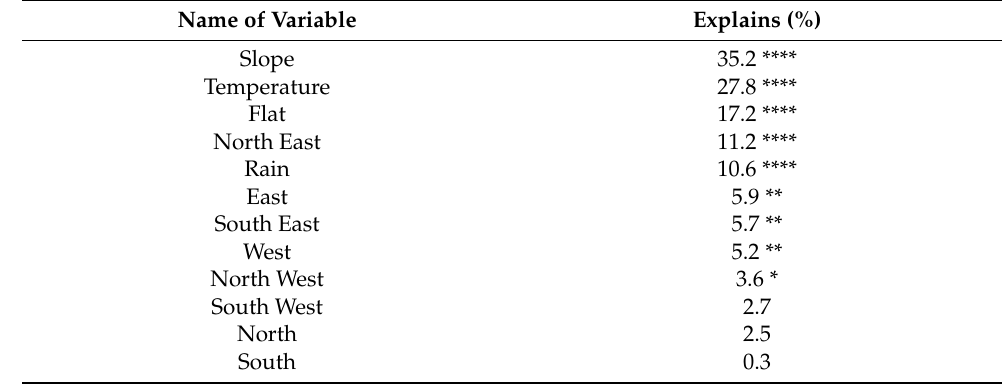
Table 3. Explanatory ability and statistical significance level of variables to the NDVI variations. Significant variables are marked with